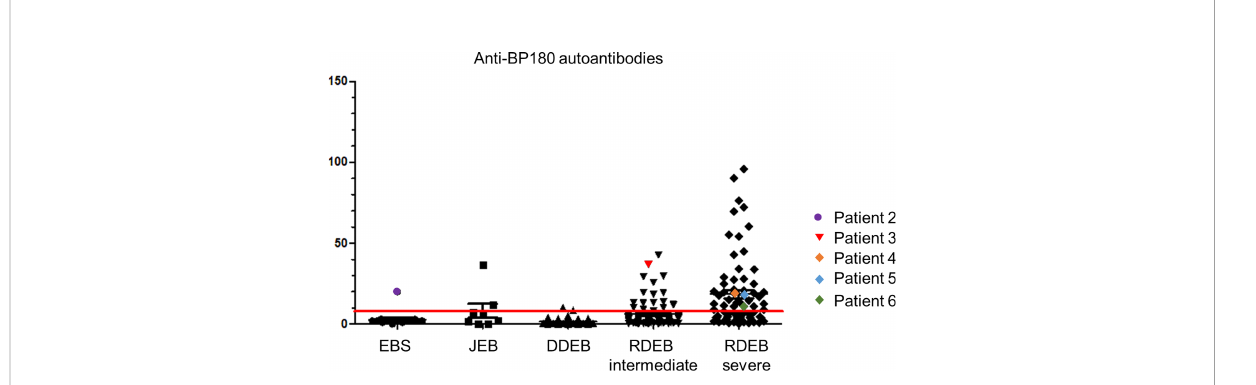
FIGURE 1 Anti-BP180 autoantibody titers of the patients in our EB-cohort. Anti-BP180 autoantibodies were detected by BP180 NC16A ELISA in patient sera. The red line indicates the upper limit norm level of 9 U/ml. EBS, EB simplex; JEB, junctional EB; DDEB, dominant dystrophic EB; RDEB, recessive dystrophic